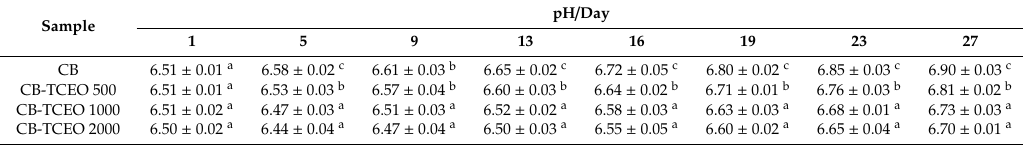
Table 4. E ff ect of the application of CB-TCEO on the pH in the muscle of Oreochromis mossambicus .